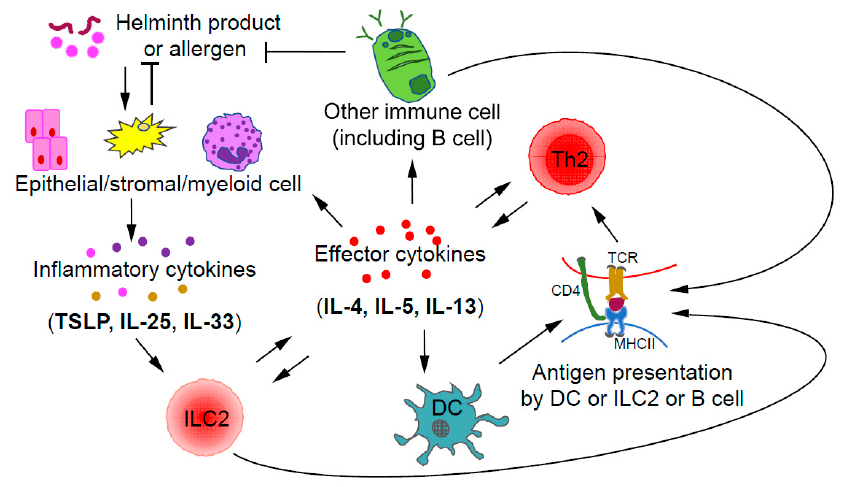
Figure 2. Crosstalk between ILC2s and Th2 cells during type 2 immune responses. Upon stimulation by helminth products or allergens, epithelial and/or stromal cells may produce inflammatory cytokines including IL-33, IL-25, and TSLP, which are capable of activating ILC2s. By producing type 2 effector cytokines, such as IL-4 and IL-13, ILC2s may promote the migration of dendritic cells (DCs) into draining lymph nodes to induce Th2 cell differentiation. Some ILC2s also express MHCII, which allows them to directly interact with Th2 cells through antigen presentation. Thus, ILC2s could promote the further differentiation of early Th2 cells; on the other hand, Th2 cells may expand ILC2s through IL-2 production. Effector cytokines including IL-4 and IL-13 produced by Th2 cells, may also indirectly induce the expansion of ILC2s through stimulating epithelial cells to produce ILC2-activating inflammatory cytokines such as IL-25 and TSLP.